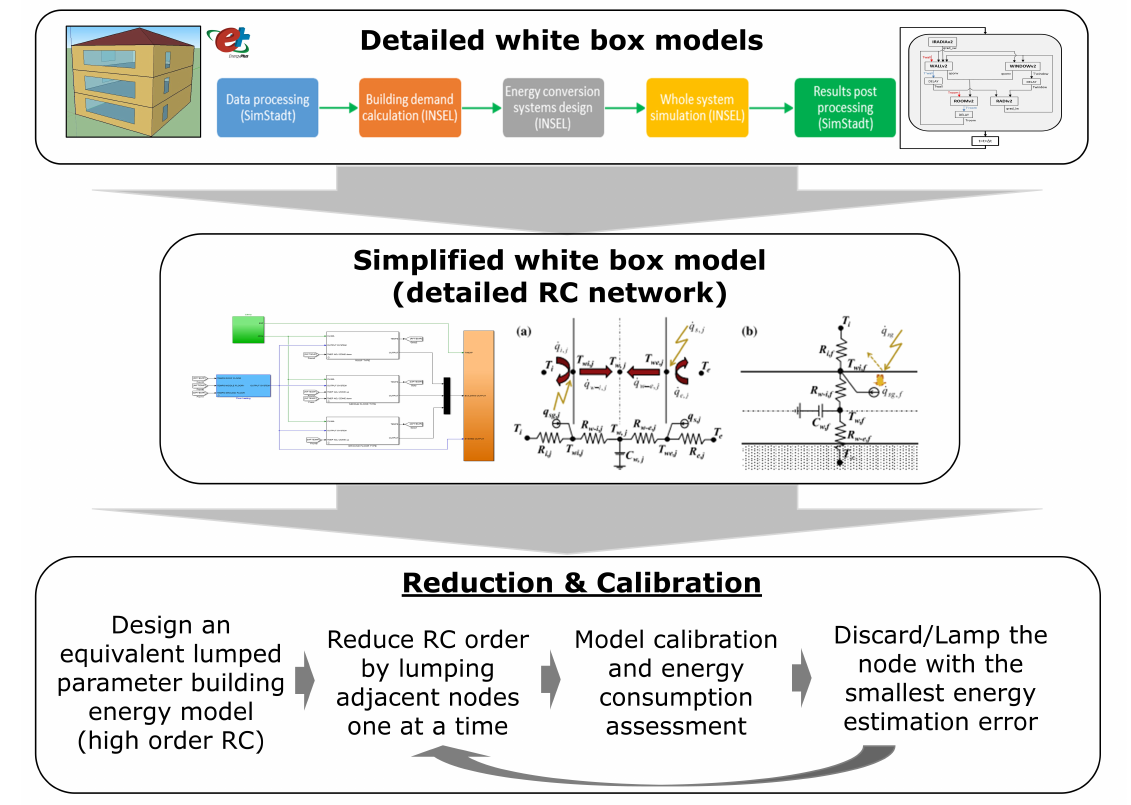
Figure 3. Schematic of the adopted methodology. Detailed white-box models: Energy+ and INSEL. Simplified white-box models: BEPS. Low order models: reduction (trimming) and calibration